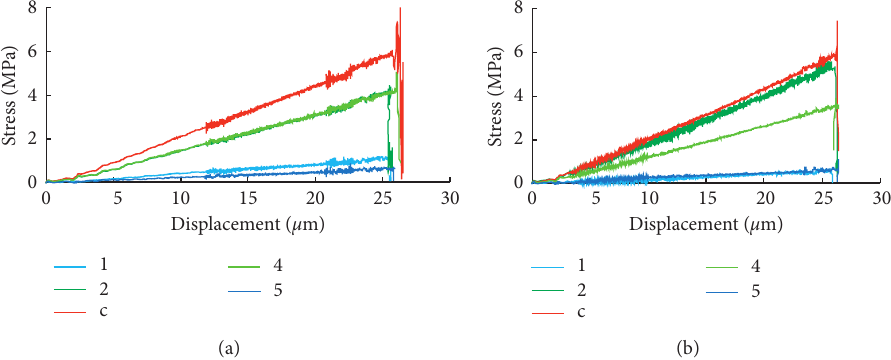
Figure 22: Loading stress-displacement curves of uneven parallel bedding models with different layer thicknesses. (a) 2 and 6. (b) 10 and